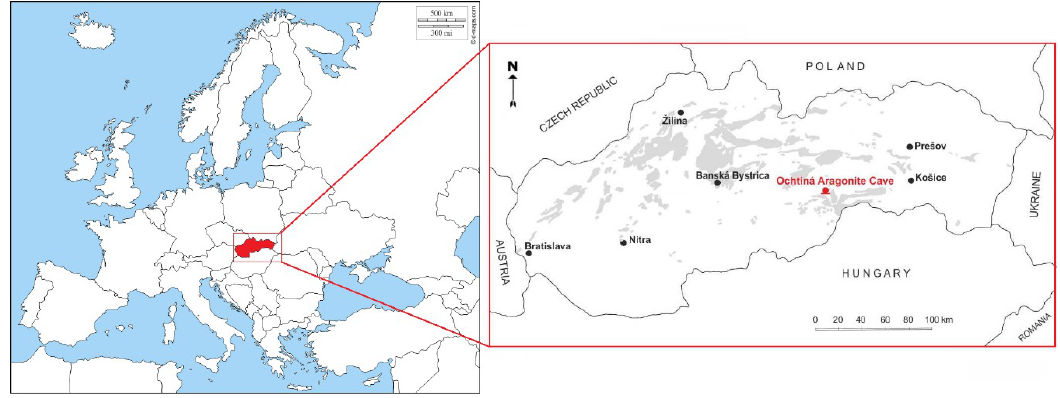
Figure 1. Location of the Ochtiná Aragonite Cave.